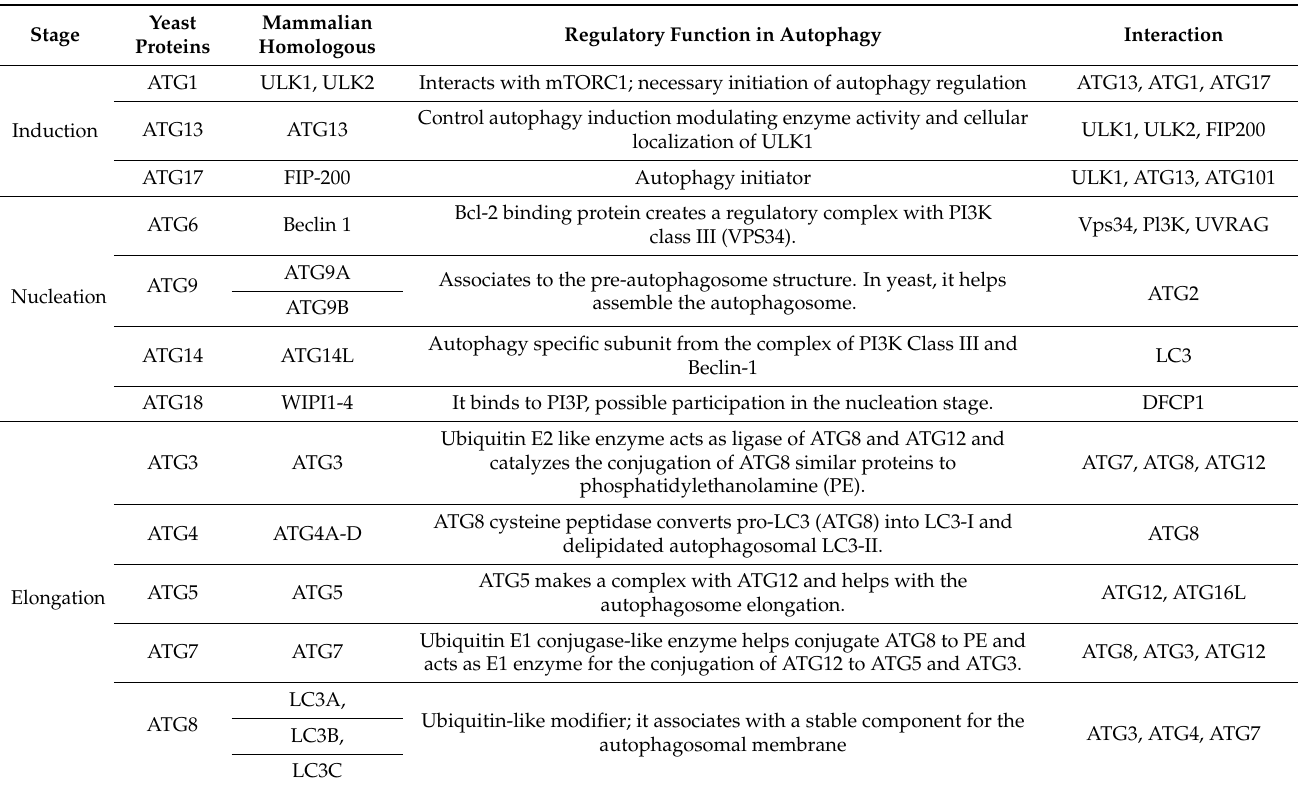
Table 3. Role of autophagy